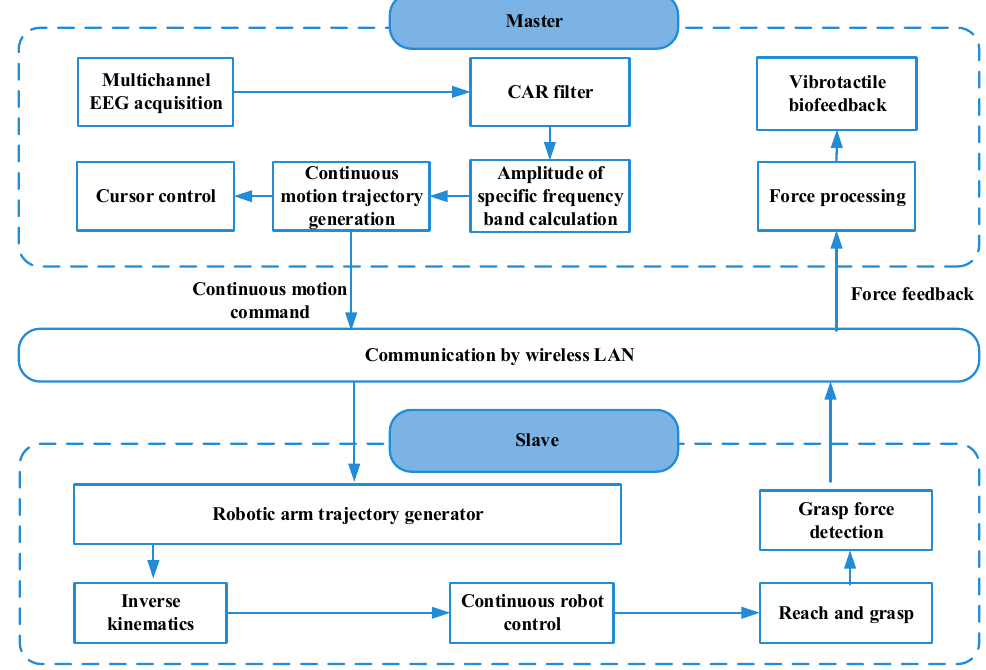
Figure 2. Control architecture of BCI-driven continuous teleoperation robot system.